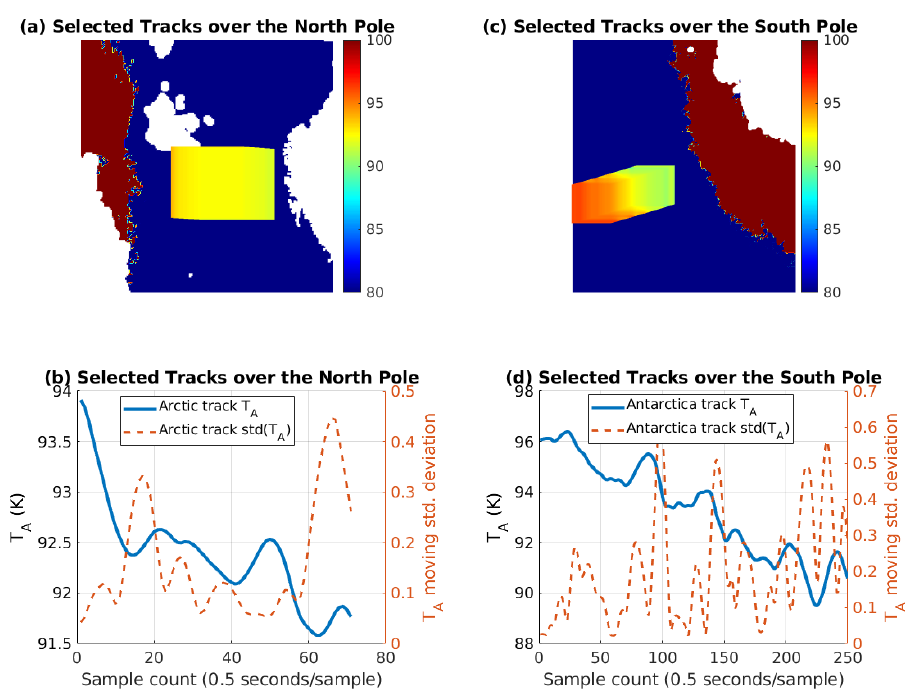
Figure 7. ( a , c ) are the Geo-located selected tracks for both North and South poles used to compute sensitivity and accuracy analysis, and ( b , d ) are the time evolution of the brightness temperature and a 5-s window standard deviation of the T A .